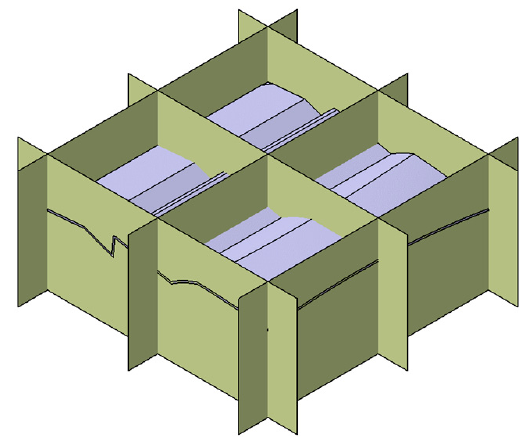
Figure 10. All six cut planes needed for segmentation of the part.